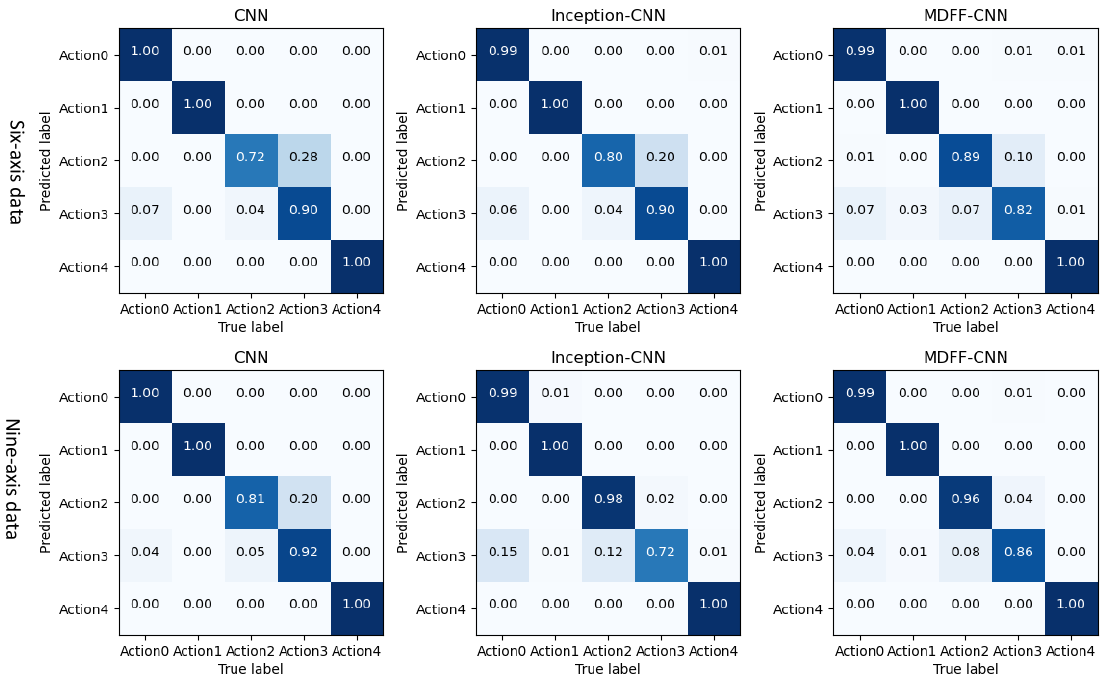
Figure 15. Recognition accuracy rate of convolutional neural network model on professional test set.